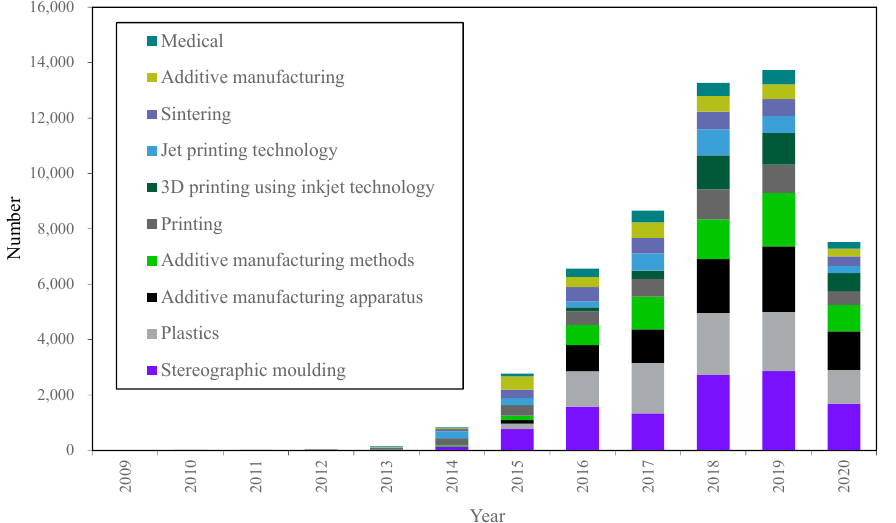
Figure 10. Annual applications and DWPI distribution of 3D printing patents.